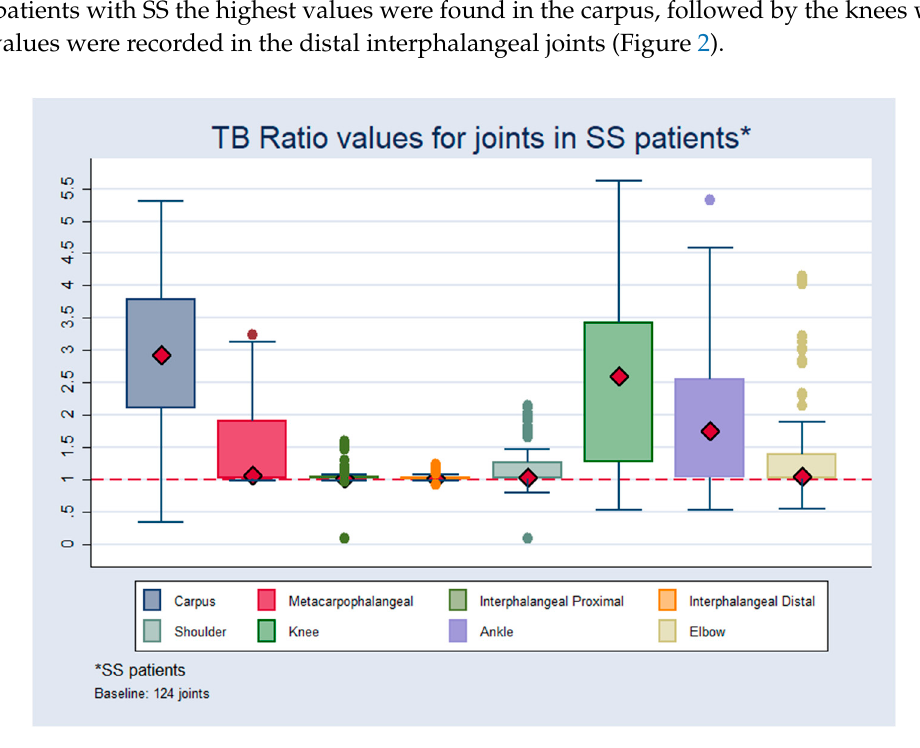
Figure 3. Example of two scans in two patients showing different degrees of 99m Tc-SST uptake in the parotid and submandibular glands (arrows), carpus (both patients positive), and knees (both patients negative).